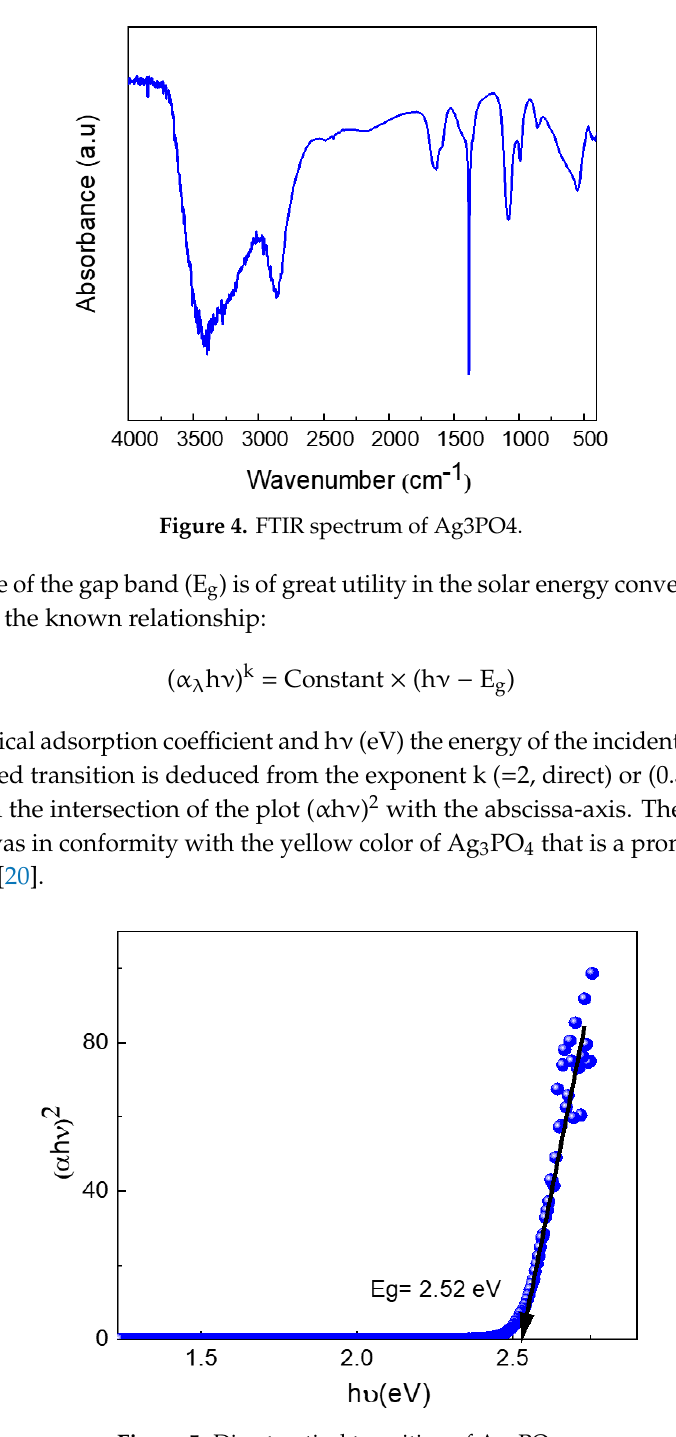
Figure 3. BET of Ag 3 PO 4 at 77 K.